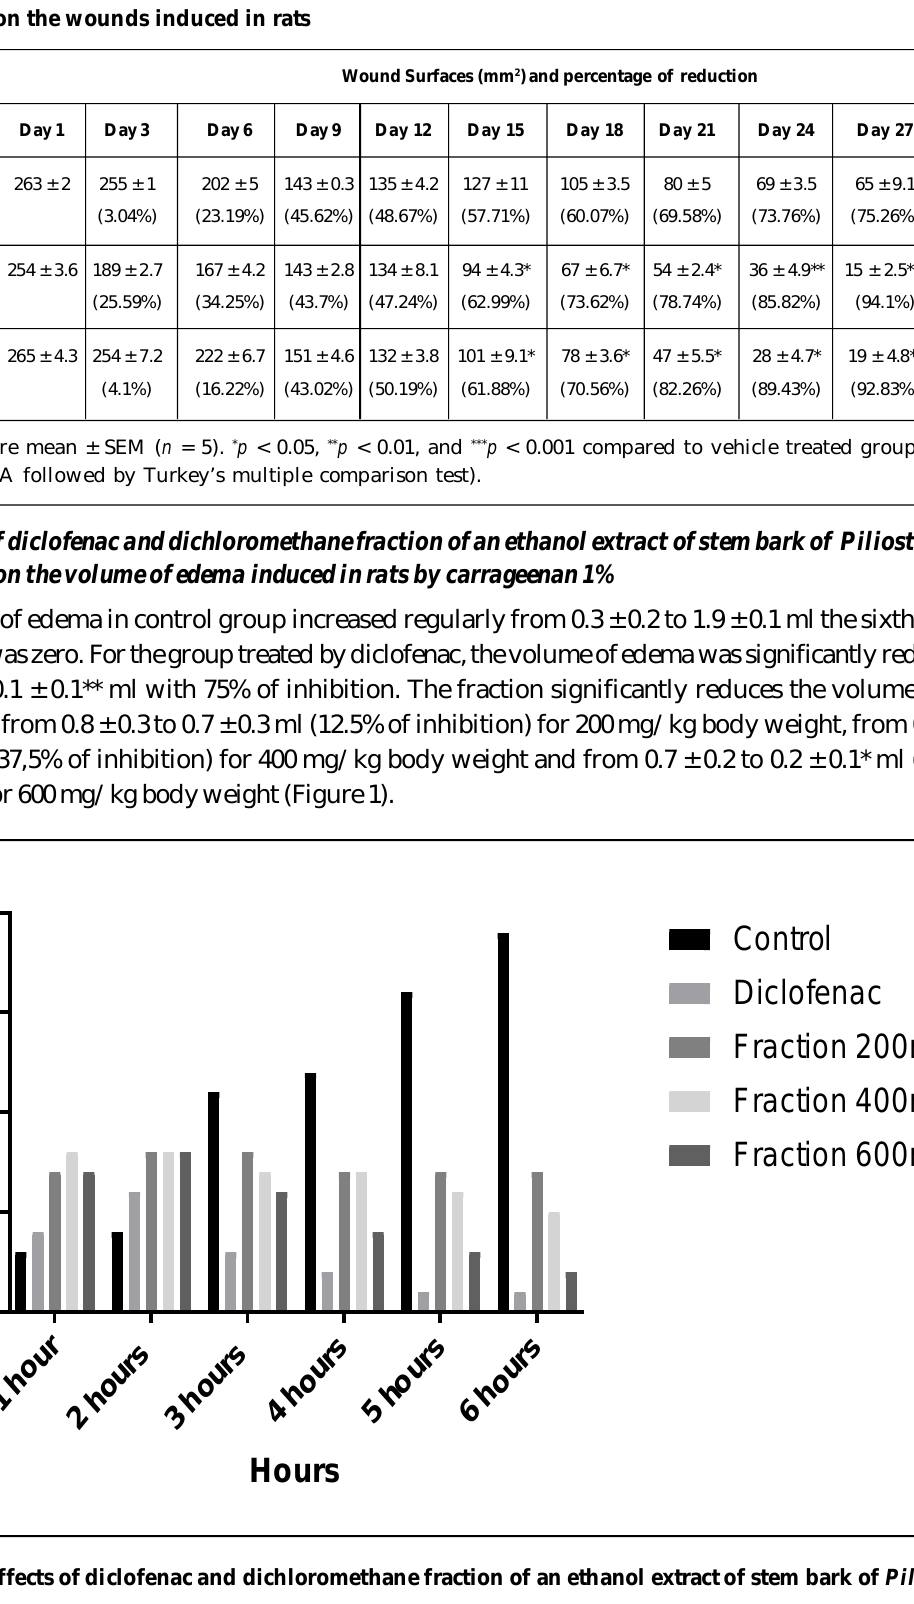
Figure 1: Effects of diclofenac and dichloromethane fraction of an ethanol extract of stem bark of Piliostigma reticulatum on the volume of edema induced in rats by carrageenan Note: One-way ANOVA followed by a Turkey’s multiple comparison